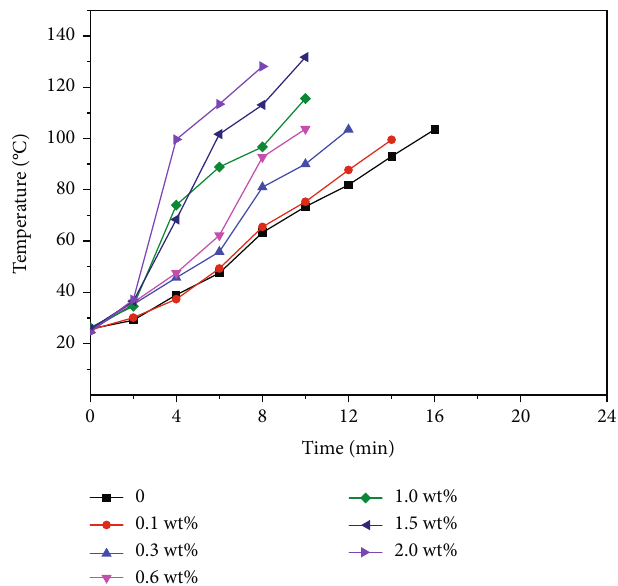
Figure 4: Temperature curves of heavy oil with time under di ff erent mass fractions of nanoparticles.